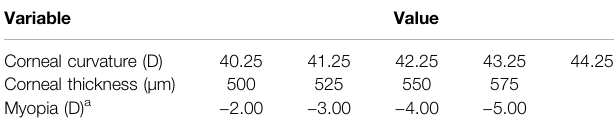
TABLE 1 | Corneal curvature, corneal thickness, and